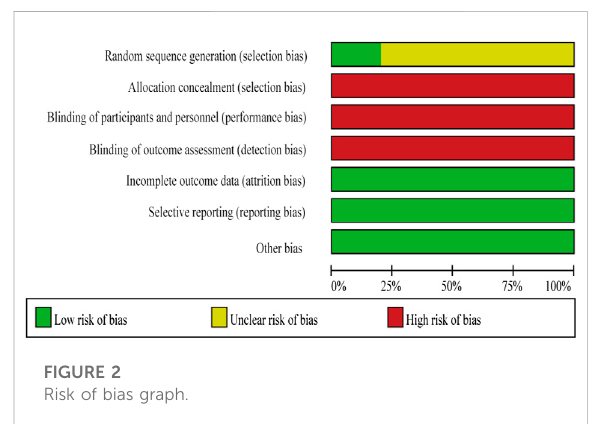
FIGURE 2 Risk of bias